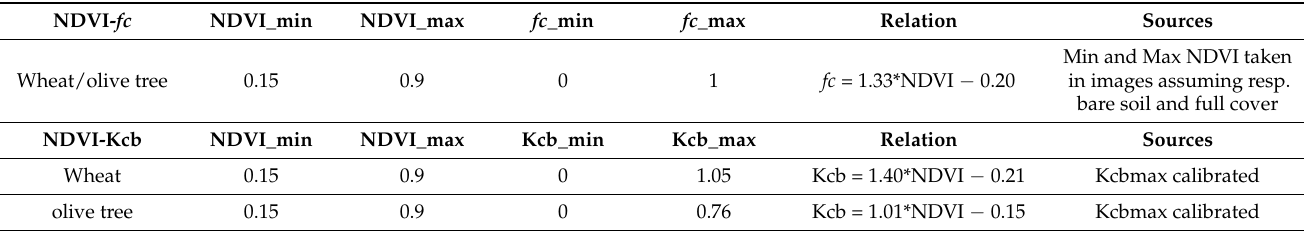
Table 1. Relations used for fractional vegetation cover ( fc ) and basal crop coefficient (Kcb) estimates from the Normalized Difference Vegetation Index (NDVI).